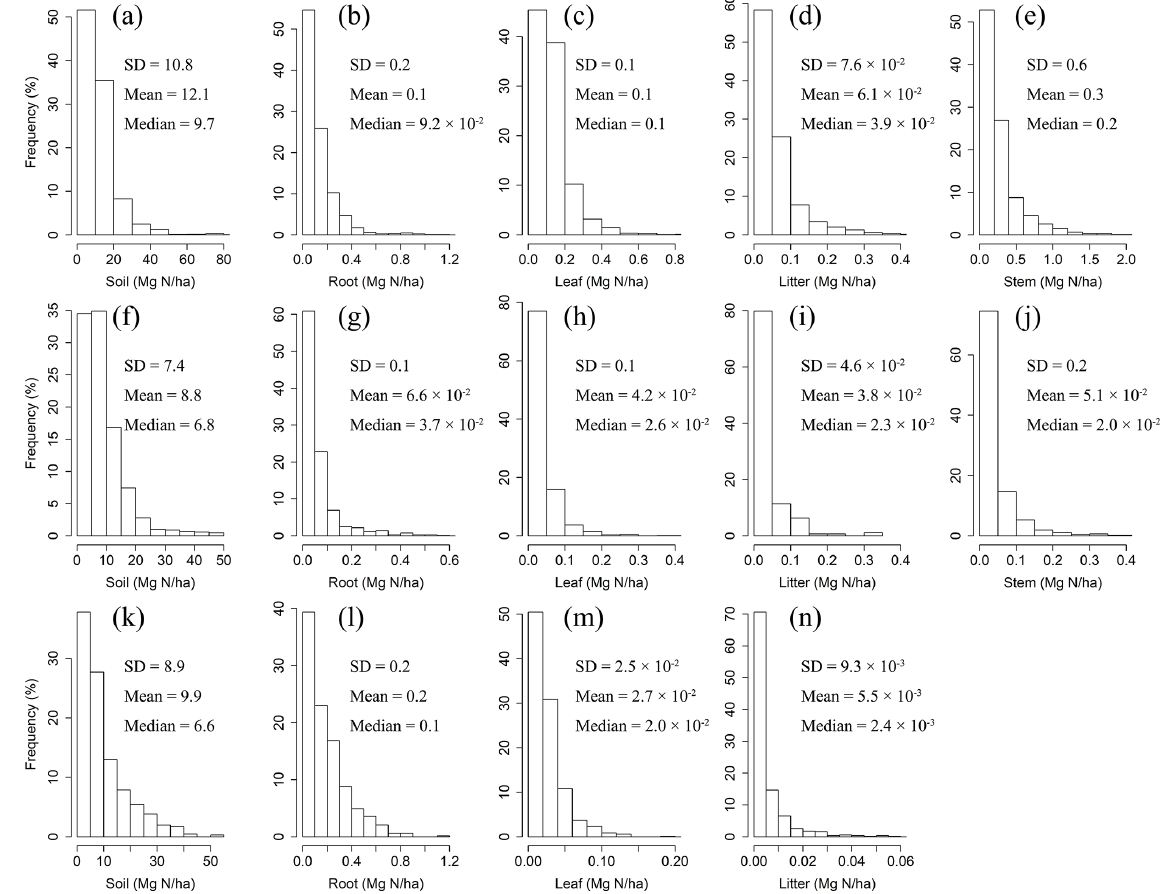
Figure 1. Frequency distributions of N densities in soil, roots, leaves, litter, and woody stems in forests (a–e) , shrublands (f–j) , and grasslands (k–n) in